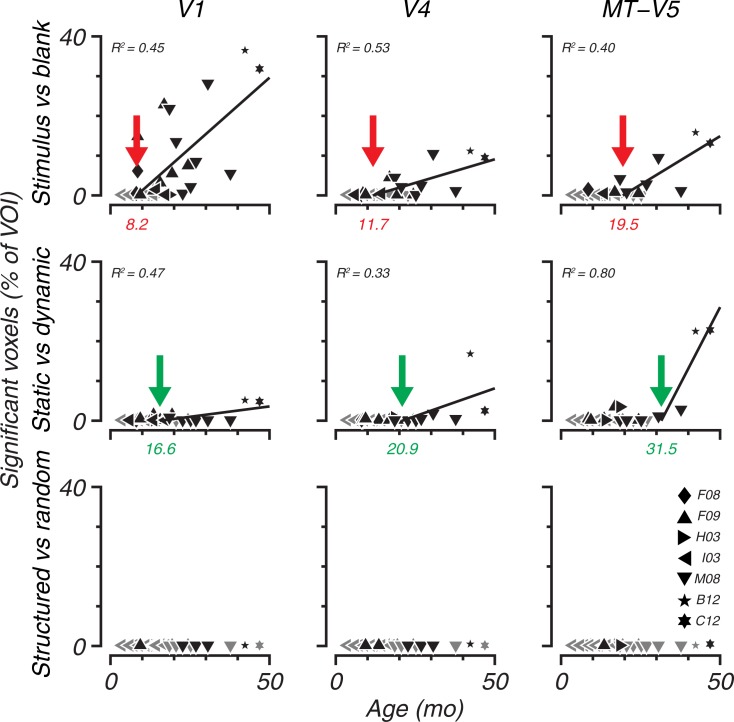
Percentage of voxels from total VOI that significantly modulated.(GLM, t-test p < 0.05, Bonferroni corrected for number of voxels within VOI) as response to Glass patterns (GPs) versus blank, Dynamic GPs versus Static GPs, and Structured GPs versus Random dipoles. Gray symbols indicate sessions where no voxels were significant. Symbol types indicate different subjects. All significant sessions are used to fit a line when four or more consecutive sessions have active voxels (linear regression by minimizing squared errors) and the explained variance in the subset of sessions are indicated as R2 (Note that all sessions are considered to be independent and colinearity or covariances are ignored). The intercepts of the lines with the abscissas are indicated with colored arrows. The ages at this intercept are shown below the axis. These values reflect the ages at which significant voxels start to appear in the VOIs. In the lowest panel (Structured versus Random) an intercept between 0 and 50 months could not be obtained.